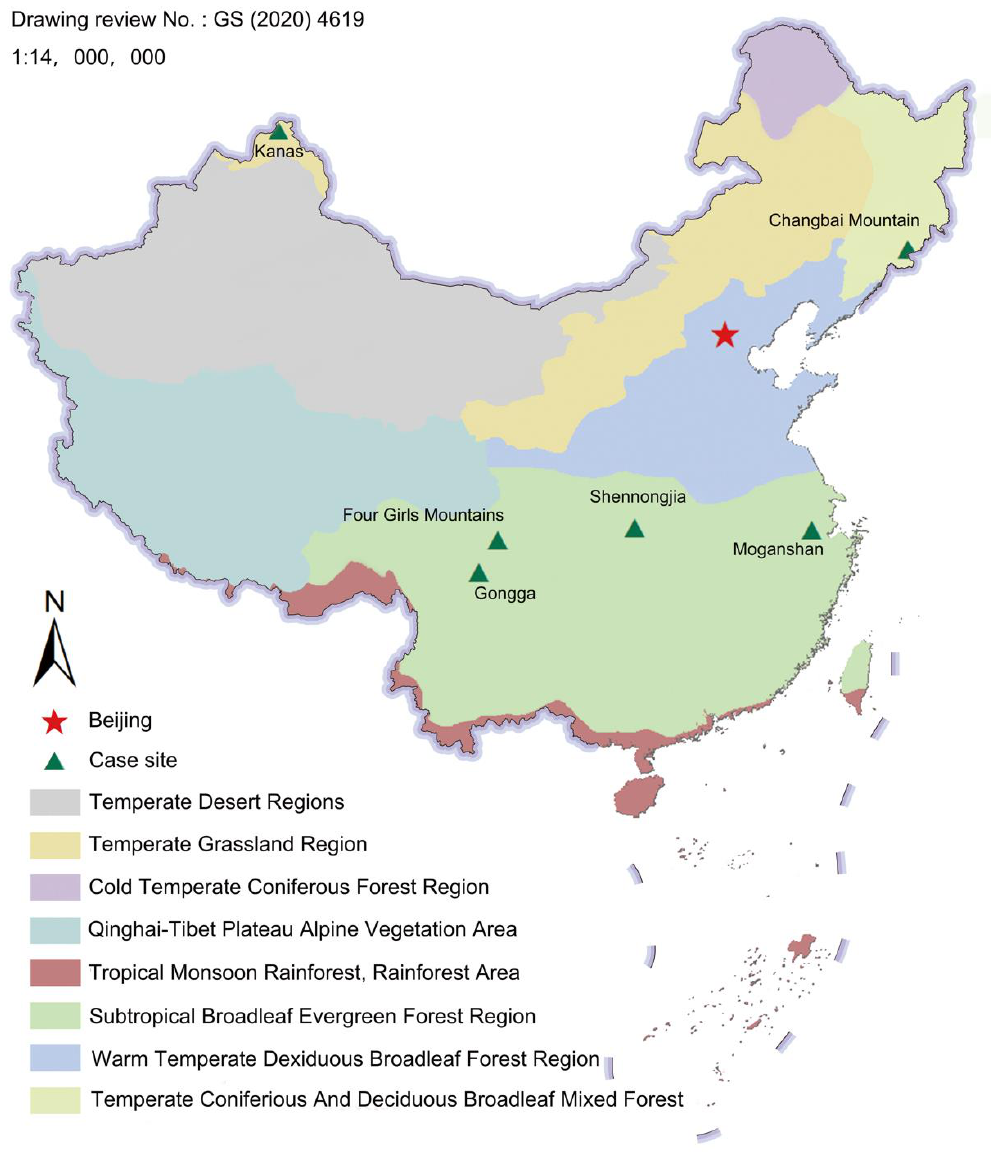
Figure 1. Schematic diagram of case site location. Chinese vegetation zoning data from the Resource and Environment Science and Data Center, Chinese Academy of Sciences. Base map according to the standard map of the Ministry of Natural Resources of China.